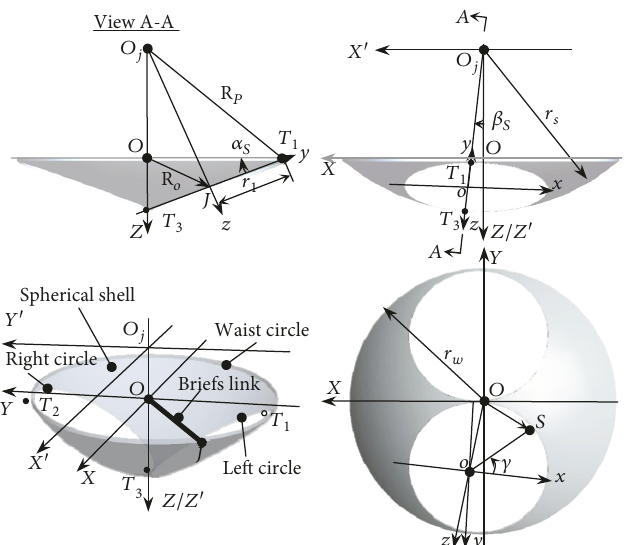
Figure 6: Model and parameters of briefs